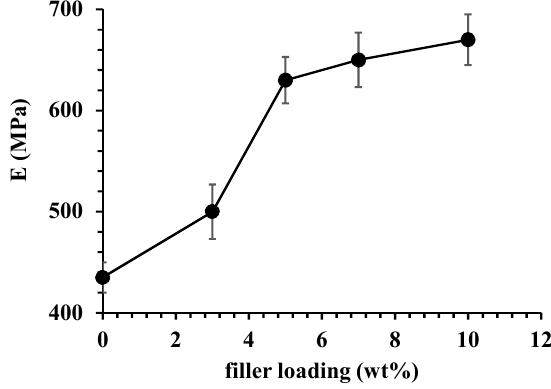
Figure 7. Elastic modulus as function of filler loading for composite materials (PA11 + Zeo-Sal).